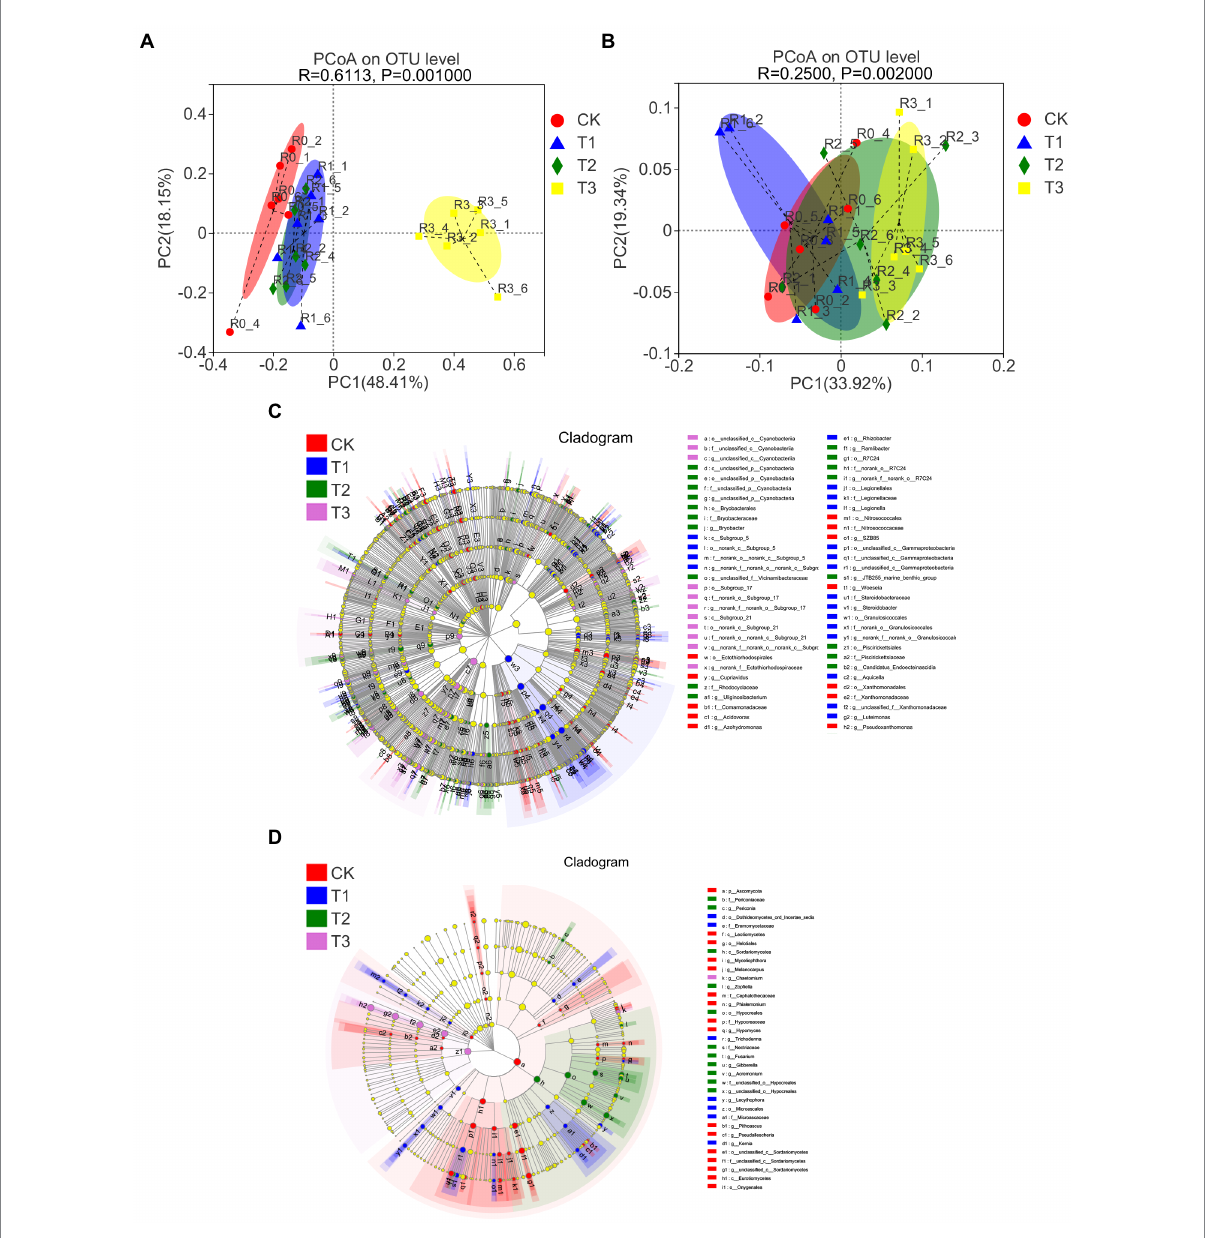
FIGURE 4 Principal coordinate analysis (PCoA) of bacterial (A) and fungal (B) OTU levels in soil at different irrigation amounts with an unweighted UniFrac distance algorithm. LEfSe analysis from the phylum to genus level, including bacteria (C) and fungi (D) , by the nonparametric factorial Kruskal– Wallis (KW) sum-rank test. n =